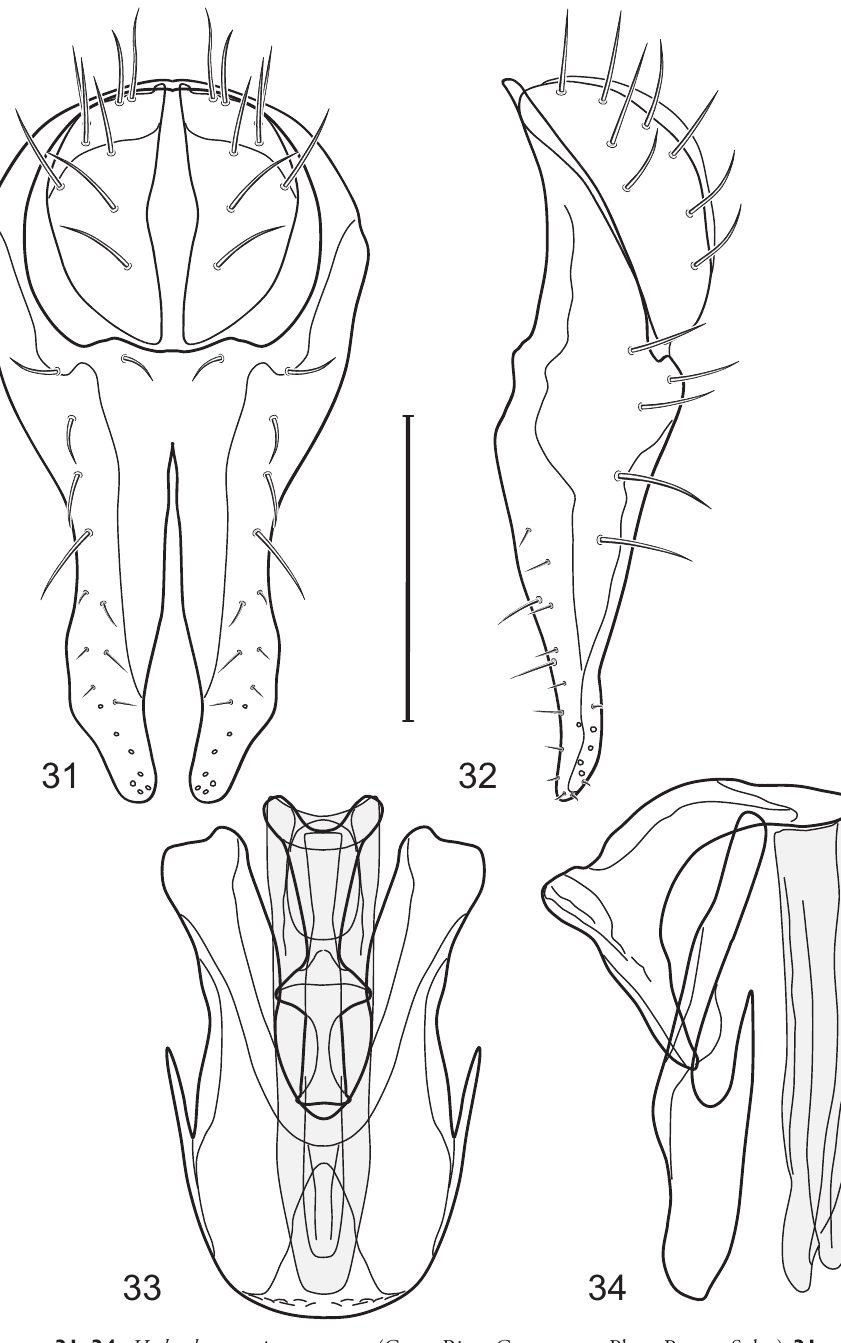
Figures 31–34. Hydrochasma rictum sp. n. (Costa Rica. Guanacaste: Playa Puerto Soley) 31 epan- drium and cerci, posterior view 32 same, lateral view 33 internal structures of male terminalia (aedeagus [shaded], phallapodeme, gonite, hypandrium), ventral view 34 same, lateral view. Scale bar = 0.1